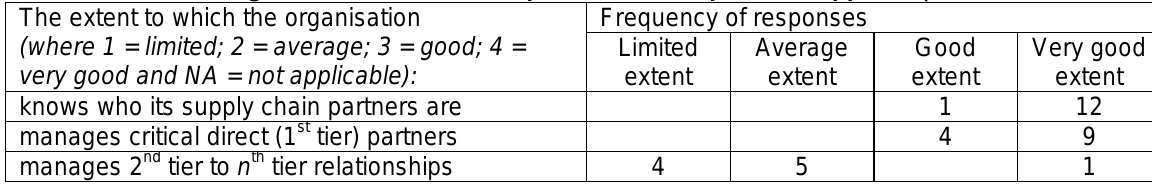
Table 6: Organisations’ relationships with their important suppliers ( n = 13) The extent to which the